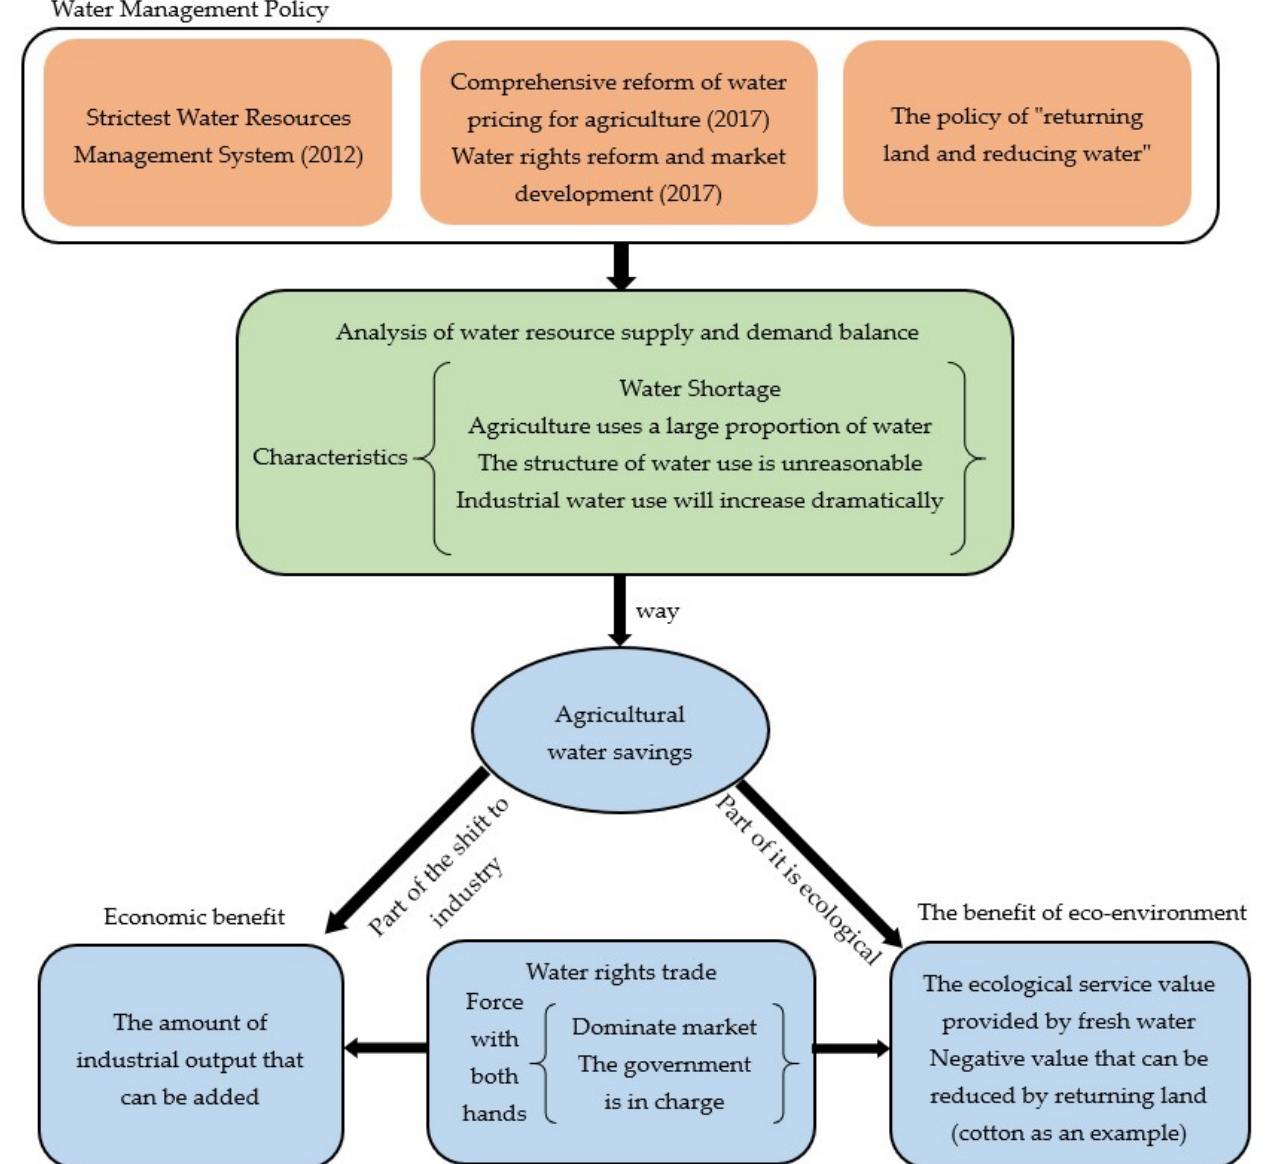
Figure 1. Water rights trading model in the arid oasis area of Xinjiang, China.